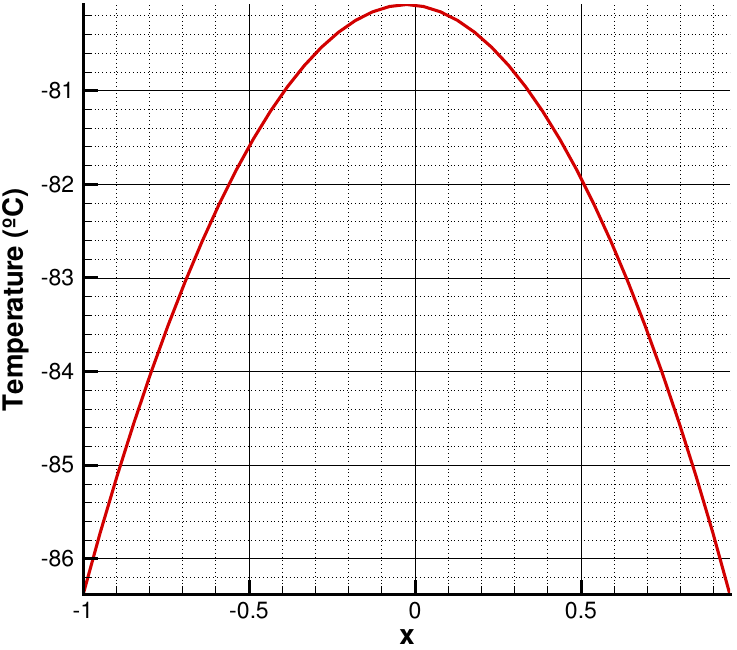
Figure 2. Stationary solution of the Energy Balance Model (EBM) model, without coupling with the deep ocean, for Q =